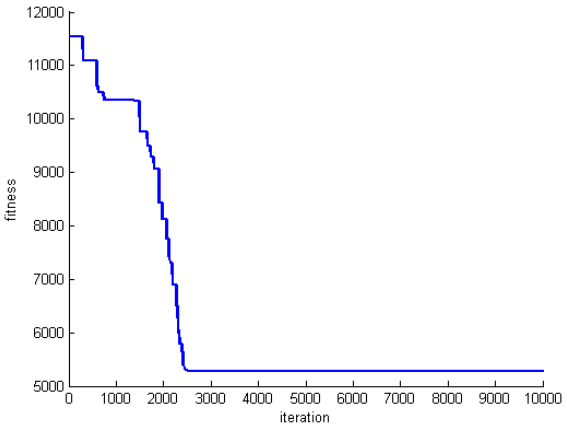
Figure 17. Changes of the best whale for a = 0 in DS 8 .